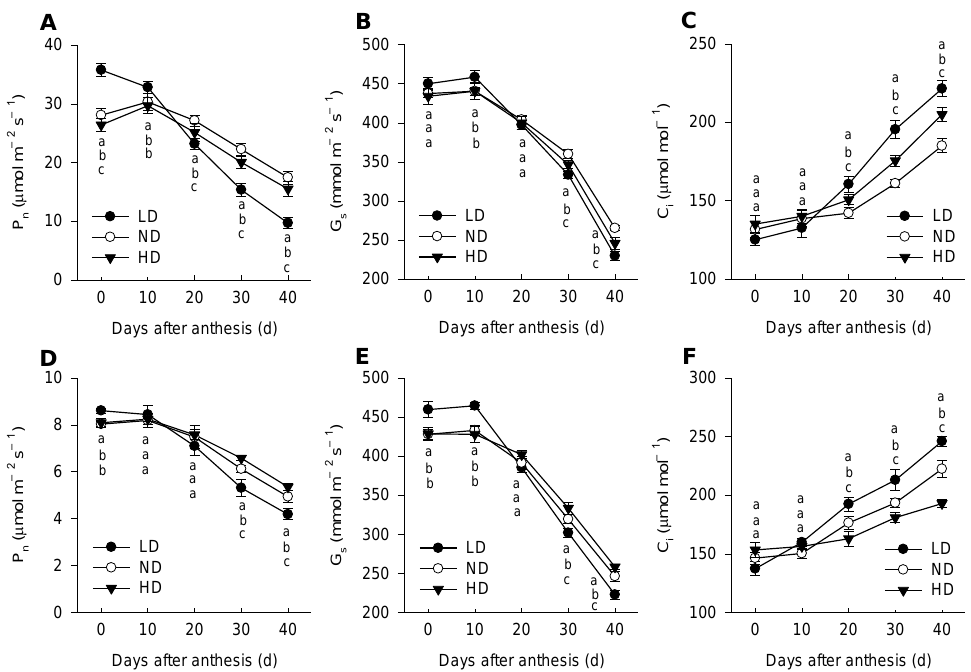
Figure 2. Changes in net photosynthetic rate (P n , ( A , D )), stomatal conductance (G s , ( B , E )), and intercellular CO 2 concentration (C i , ( C , F )) of maize leaves under high-light (HL, 1600 µ mol m − 2 s − 1 ; ( A – C )) and low-light (LL, 300 µ mol m − 2 s − 1 ; ( D – F )) conditions. Means ± SD, n = 5. Different letters (a, b, c) denote statistical differences by LSD test ( p ≤ 0.05) between different treatments. LD, low density; ND, normal density; HD, high density. Results from the light response curves, expressed using a non-rectangular hyperbola model, are shown in Table 1. The maximum gross photosynthetic rates (A max ) of leaves from ND and HD plants were only significantly higher than that of LD leaves at 30 d (23.3%, 33.2%) and 40 d (29.1%, 45.8%) after anthesis. In contrast, the rate of dark respira- tion (R d ) decreased significantly in the order LD > ND > HD within each growth stage (Table 1). The apparent quantum efficiency (AQE), representing the utilization efficiency of low light, increased in the order LD < ND < HD, with significant differences at 20, 30, and 40 d after anthesis. In addition, the light compensation point (LCP) decreased in the order LD > ND > HD at 10, 20, 30, and 40 d after anthesis; however, the maximum LCP was observed in ND at 0 d after anthesis. A similar pattern was observed for the light saturation point (LSP). Table 1. Mean values ± SD ( n = 3) of photosynthetic parameters derived from the photosynthetic photon flux density (PPFD) response curves in maize plants grown under low (LD), normal (ND), and high density (HD) planting at 0, 10, 20, 30, and 40 d after anthesis. Different lowercase letters (a, b, c) denote statistical differences by LSD test ( p ≤ 0.05) between different treatments .